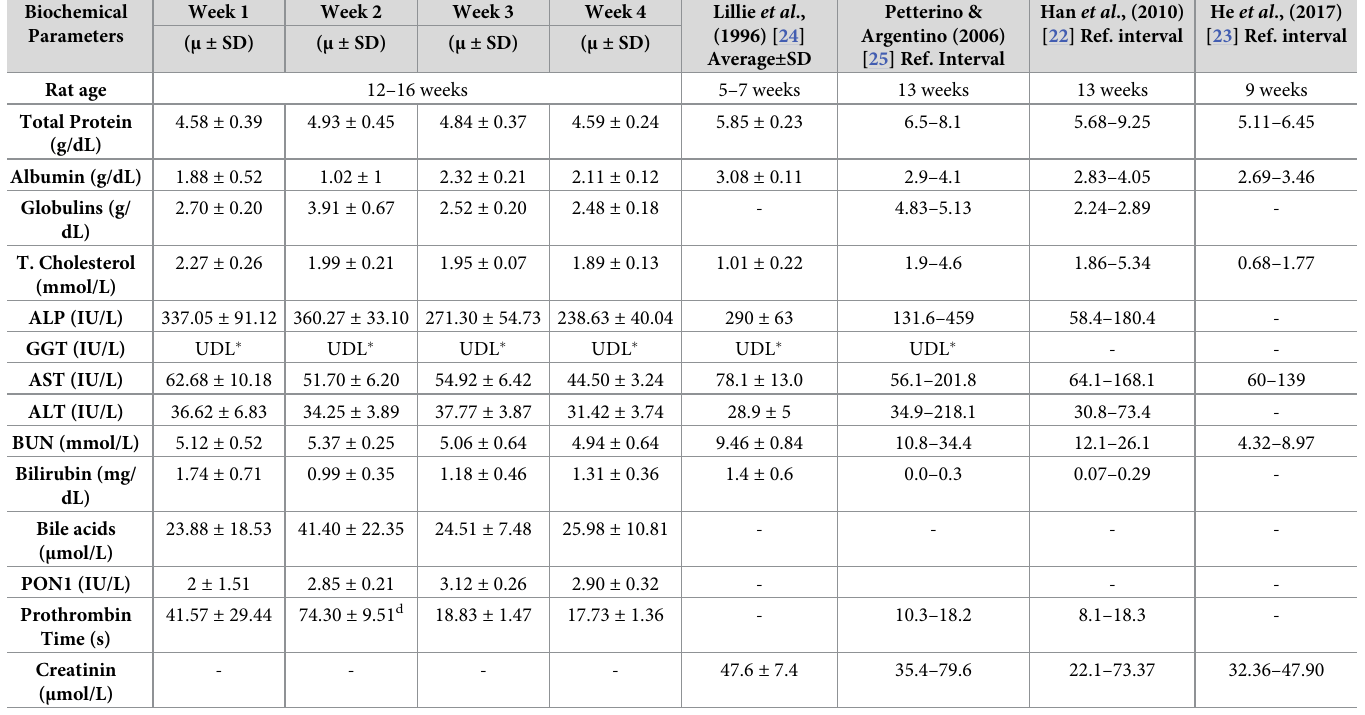
Table 2. Blood biochemical analysis and published reference values for biochemical analytes in male Sprague-Dawley rats. Biochemical Parameters